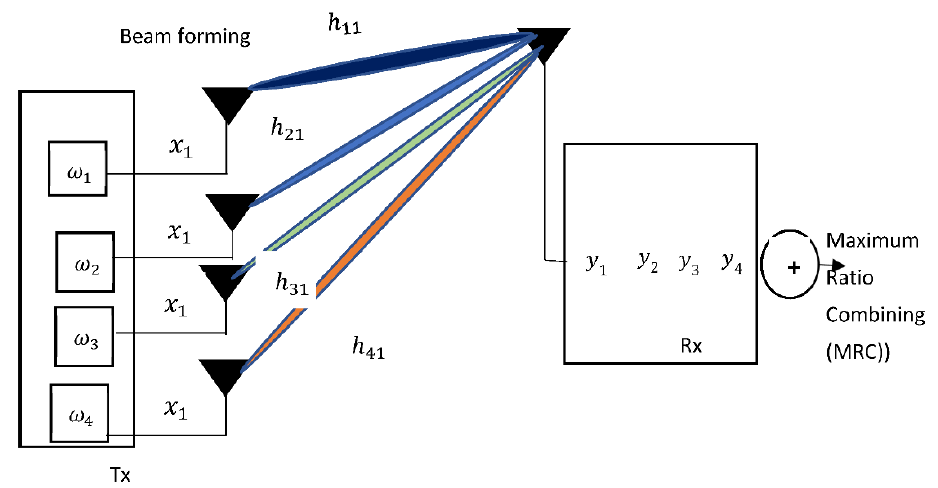
Figure 16. Schematic Diagram of Transmit MIMO beamforming.